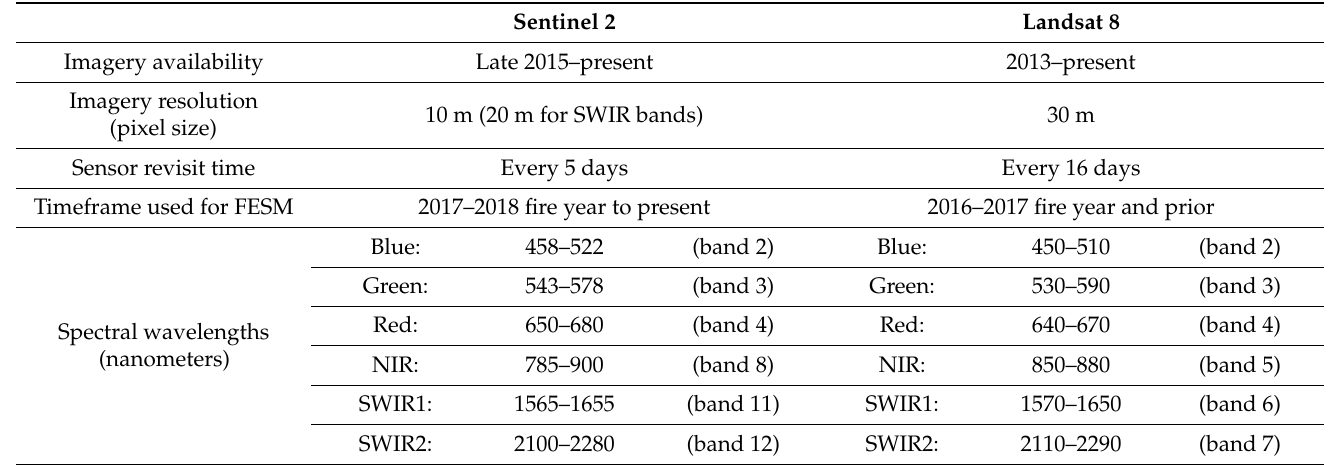
Table 1. Details of Sentinel 2 and Landsat 8 satellite sensors (adapted from Flood